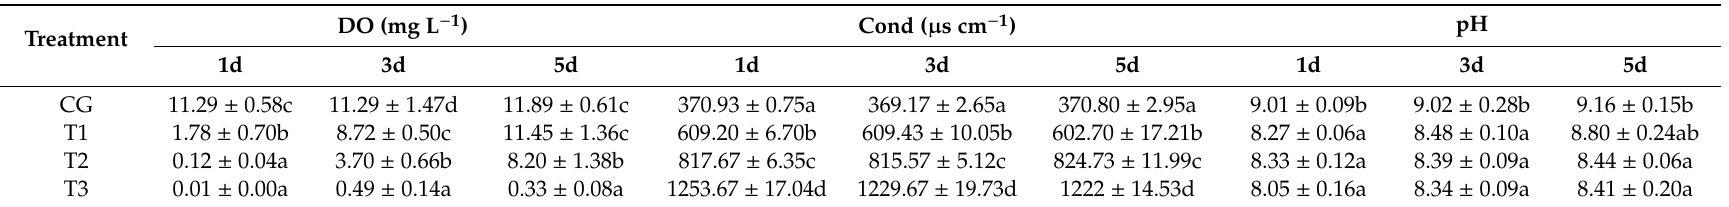
Table 3. Monitoring data of pH, DO, and Cond in culture